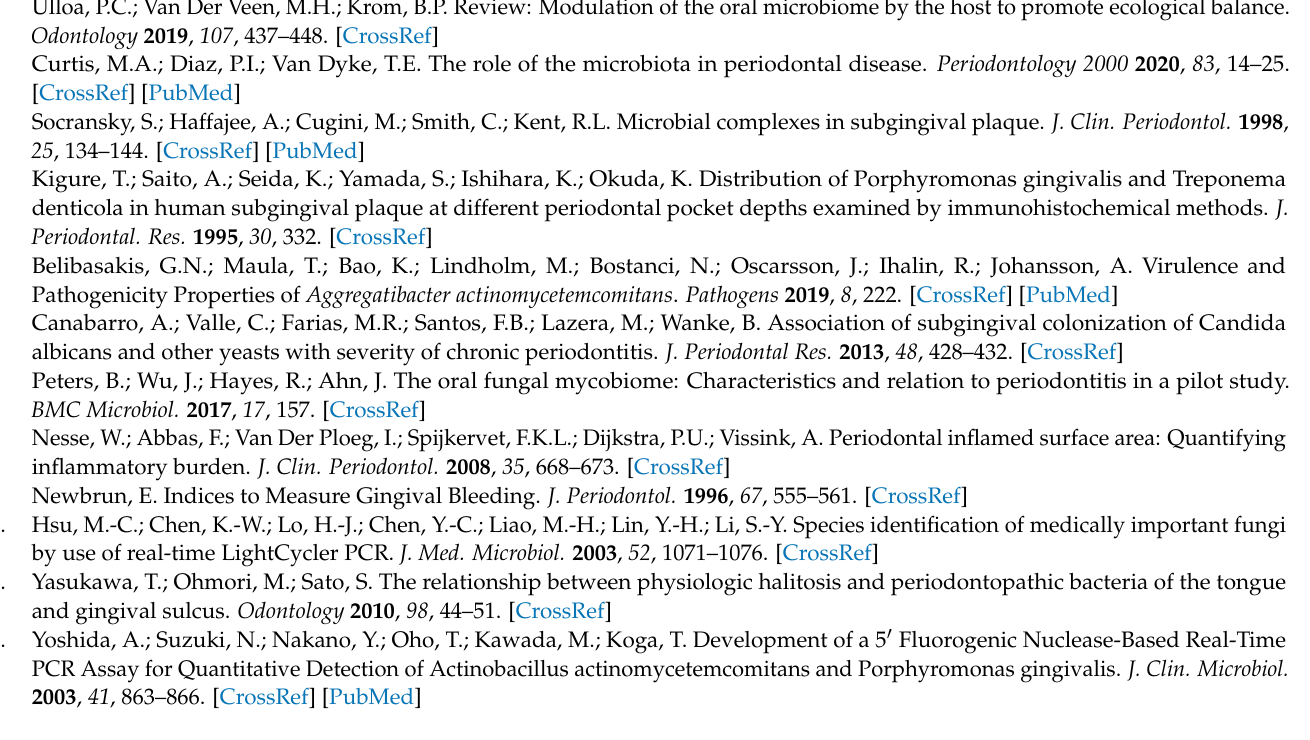
Table S4: Multivariable analysis with the presence of P. gingivalis / T. forsythia as dependent valuable, Table S5: Multivariable analysis with the presence of P. gingivalis / T. denticola as dependent valuable, Table S6: Multivariable analysis with the presence of T. forsythia / T. denticola as dependent valuable, Table S7: Multivariable analysis with the presence of P. gingivalis / T. forsythia / T. denticola as dependent valuable, Table S8: Multivariable analysis with the presence of C. albicans as dependent valuable, Table S9: Multivariable analysis with the presence of P. gingivalis / C. albicans as dependent valuable, Table S10: Multivariable analysis with the presence of T. forsythia / C. albicans as dependent valuable, Table S11: Multivariable analysis with the presence of T. denticola / C. albicans as dependent valuable, Table S12: Multivariable analysis with the presence of P. gingivalis / T. forsythia / C. albicans as dependent valuable, Table S13: Multivariable analysis with the presence of P. gingivalis / T. denticola / C. albicans as dependent valuable, Table S14: Multivariable analysis with the presence of T. forsythia / T. denticola / C. albicans as dependent valuable, Table S15: Multivariable analysis with the presence of P. gingivalis / T. forsythia / T. denticola / C. albicans as dependent